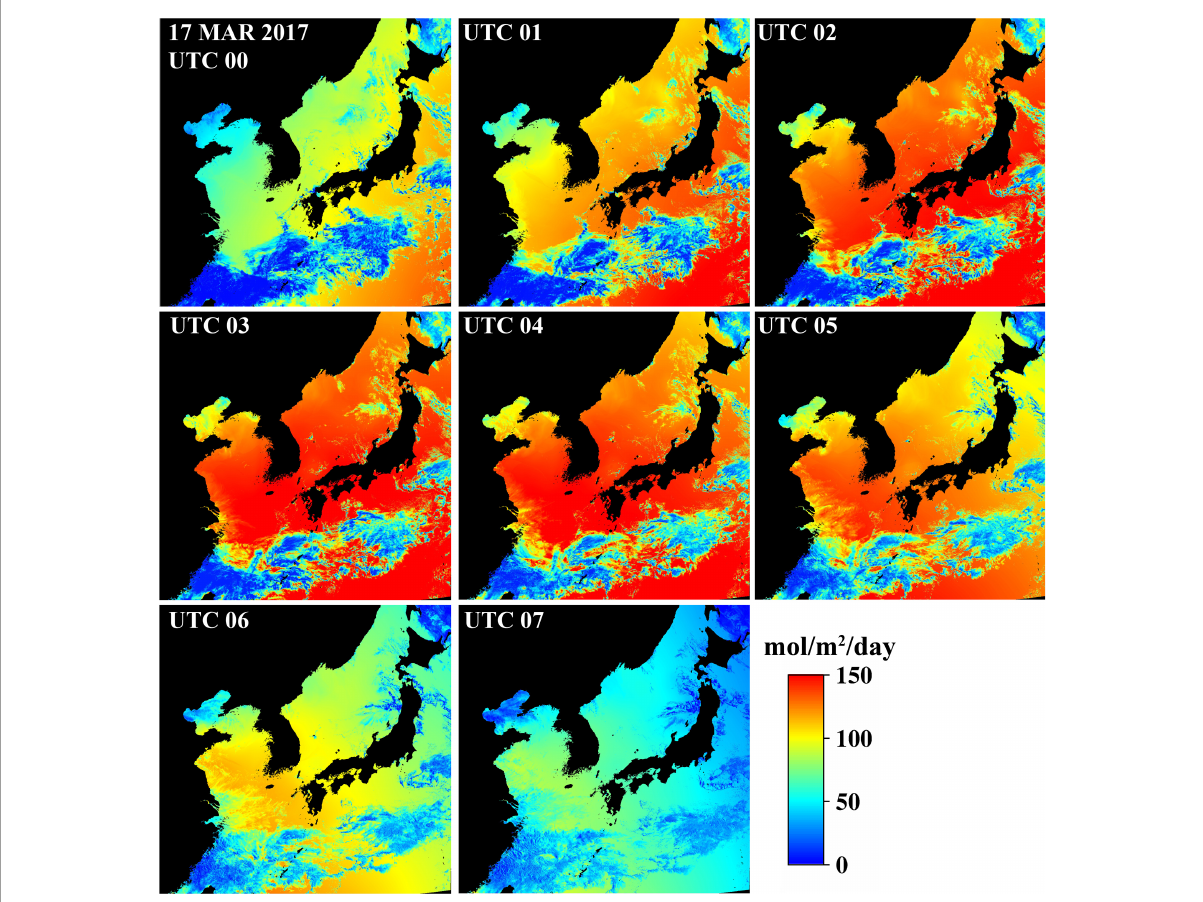
FIGURE 9 Time series images of GOCI iPAR captured on March 17, 2017. Captured times are marked in the top left of each image. The unit of iPAR is mol/ m 2 /